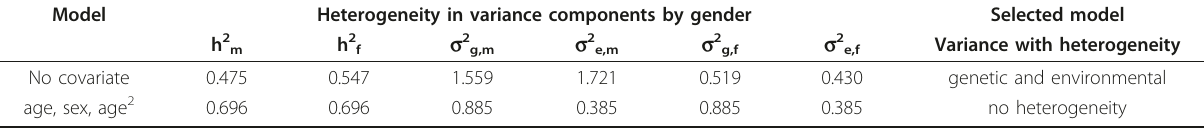
Table 4 Parameter estimates from heterogeneity analysis in variance-components by gender for smoking initiation. Model